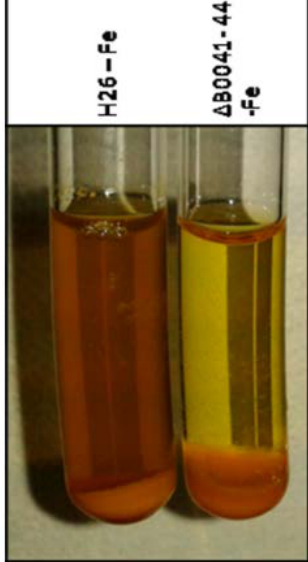
Figure 6. Experimental analysis of siderophore production and export. The wild type (left) and the iuc gene deletion mutant (right) were grown in the absence of iron in the medium. The cells were pelleted and FeCl 3 was added to the supernatant. Development of a brown color indicates the presence of a Fe 3+ siderophore in the culture supernatant.